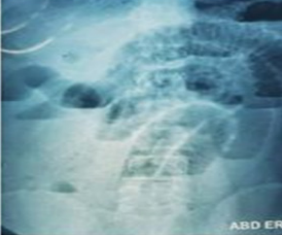
Fig. 2: Plain X-ray abdomen: Erect: Showing multiple air fluid level